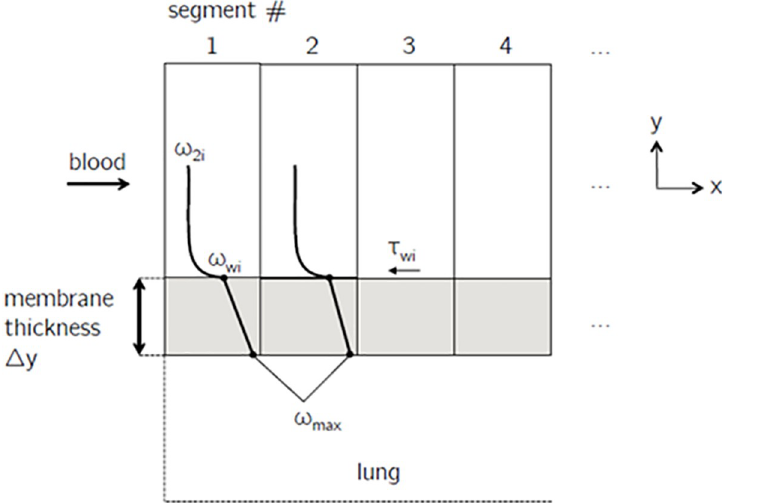
Fig 10. Convective mass transfer model for X . derbentina ’s vein